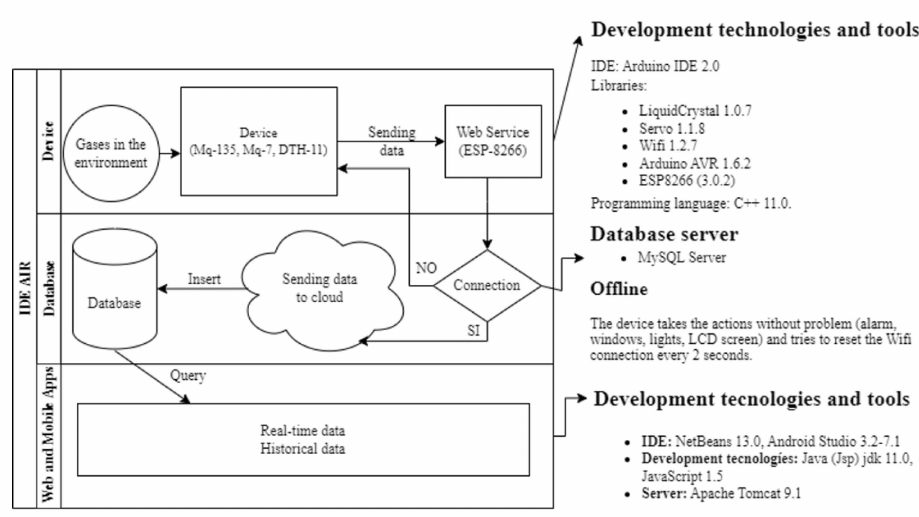
Figure 4. Data capture and alerting